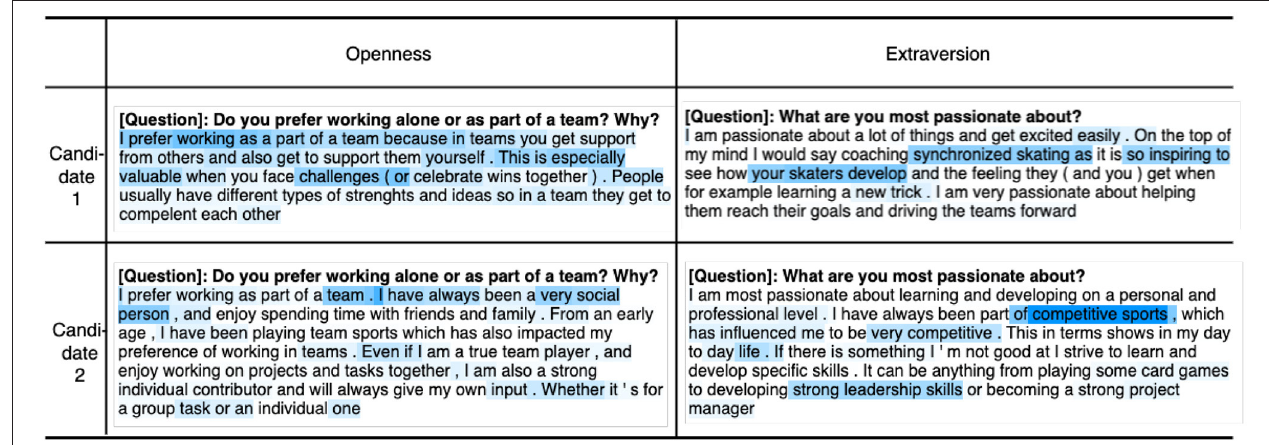
FIGURE 4 | Visualization of attentions from InterveiwBERT along with corresponding tokens for openness (O) and extraversion (X). Tokens with higher attention are in darker color.